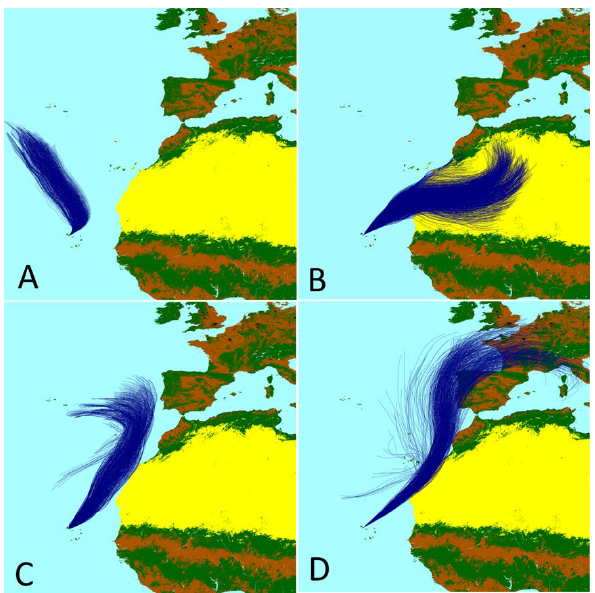
Figure 1. Typical 96h air mass back trajectory ensembles calcu- lated for CVAO during the routine filter sampling periods; aerosol type and PM 10 mass concentration are given in parentheses: (a) 2 May 2011: marine air mass from the North Atlantic Ocean (mass, m = 8 . 28µgm − 3 ); (b) 14 January 2011: Saharan air mass (dust loaded, m = 155 . 04µgm − 3 ); (c) 12 July 2008: slightly polluted air mass from the northwestern African coast and the Canary Islands, m = 21 . 61µgm − 3 ; and (d) 2 February 2011: air mass from Europe crossing the coastline of NW Africa and the Canary Islands (anthro- pogenically influenced, m = 64 . 89µgm − 3